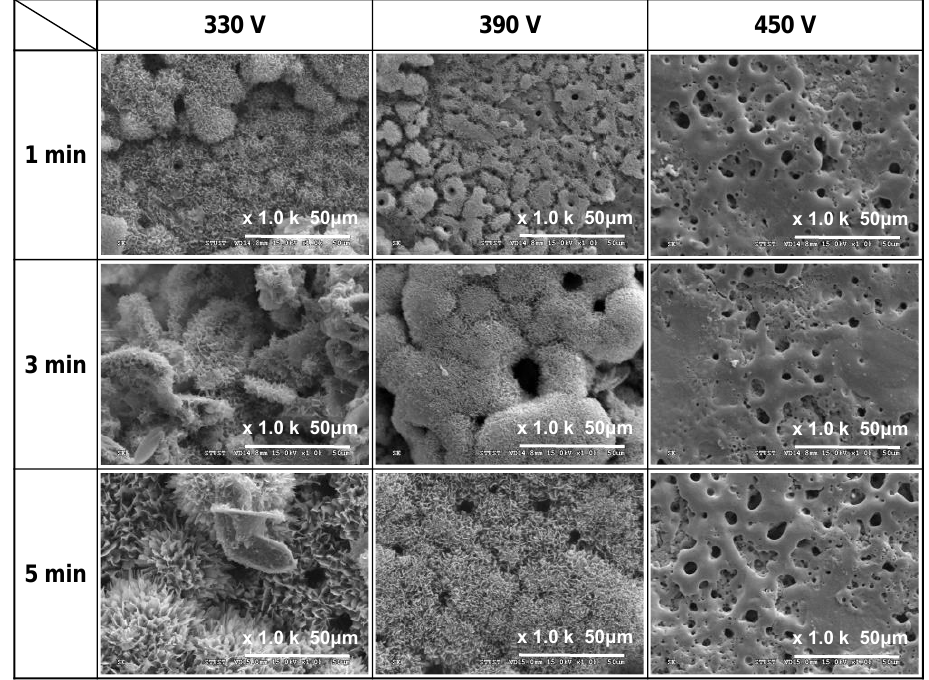
Figure 1. Surface morphologies of MAO coatings prepared with different applied voltages and duration times and constant applied current of 0.4 A.